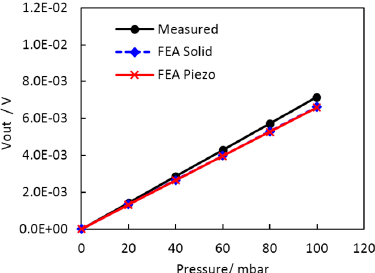
Figure 4. Simulated sensor output versus pressure (simplified model, denoted as FEA Solid, and piezo-resistive domain analysis, denoted as FEA Piezo) and measured characteristics of the 100-mbar sensor with a glued metal tube at 25 °C.